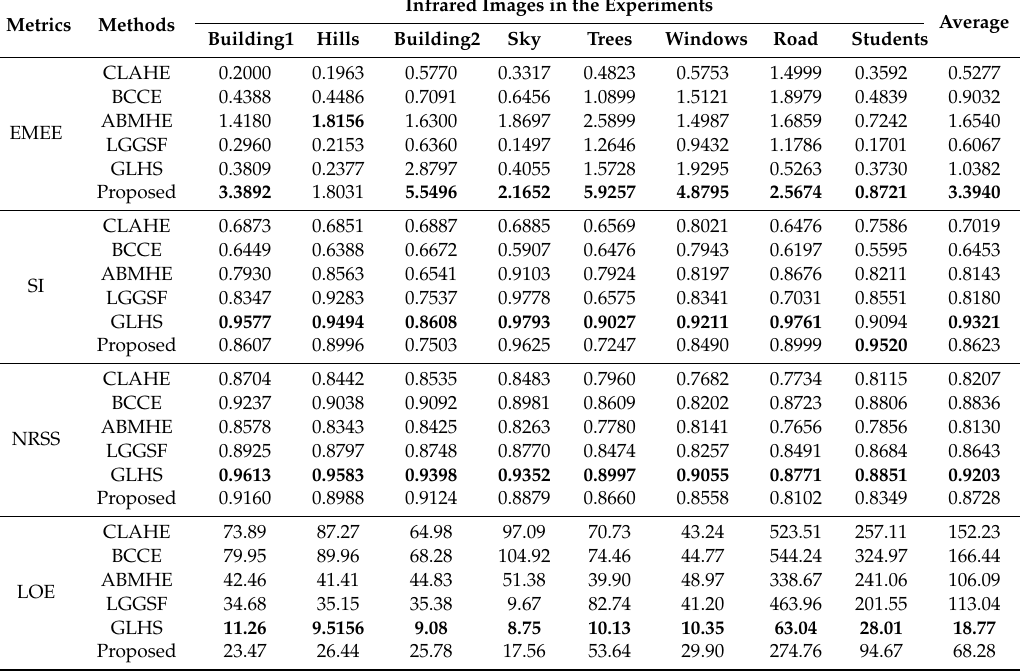
Table 1. The quantitative evaluation results of contrast-limited adaptive histogram equalization (CLAHE), balanced CLAHE and contrast enhancement (BCCE), adjacent-blocks-based modification for local histogram equalization (ABMHE), local gradient-grayscale statistical feature (LGGSF), global and local histogram specification (GLHS), and the proposed method in terms of enhancement by entropy (EMEE), structural index (SI), no-reference structural sharpness (NRSS), and lightness order error